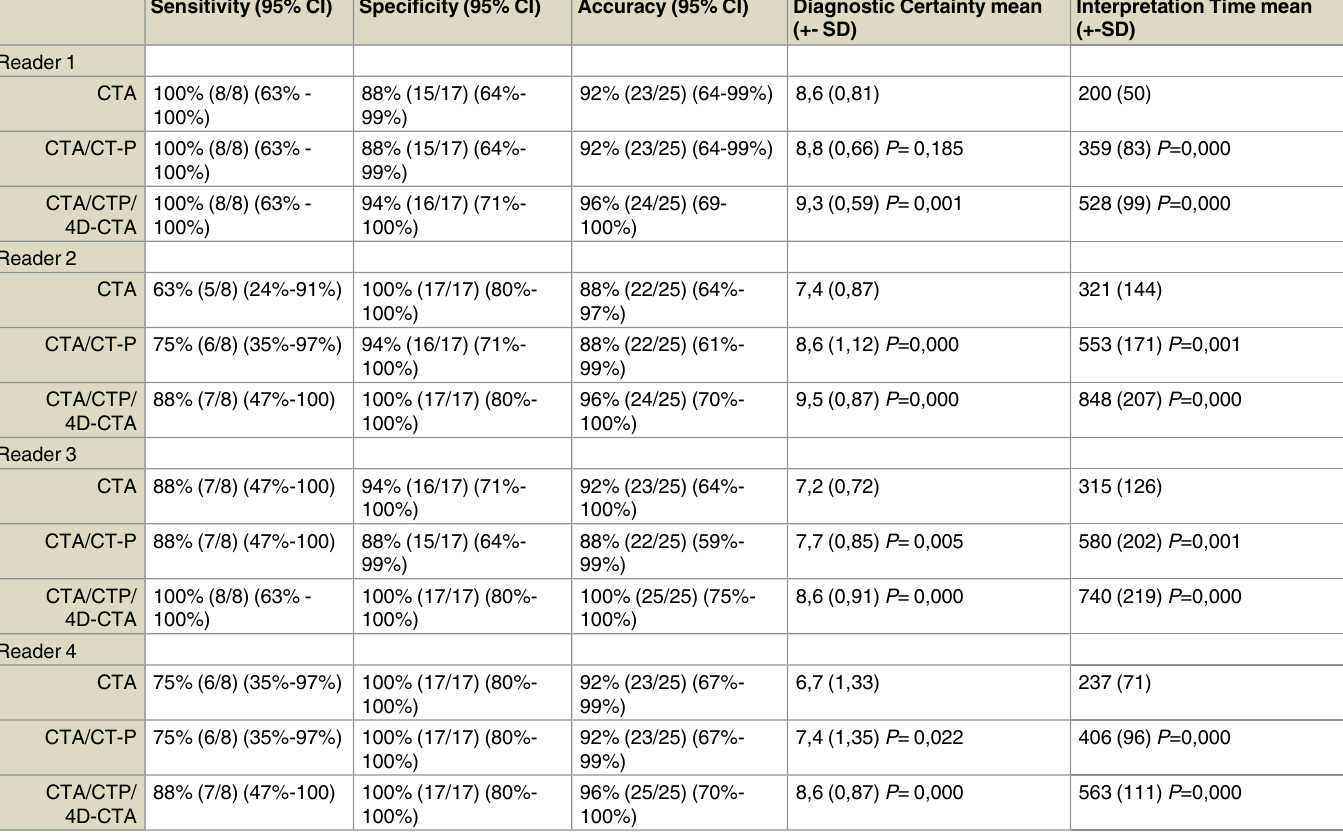
Table 2. Performanceof the individual readers1 to 4. Sensitivity, Specificity and accuracyin %. DiagnosticCertainty Scale 1–10 (10 being absolutelycer- tain). Mean interpretation time in